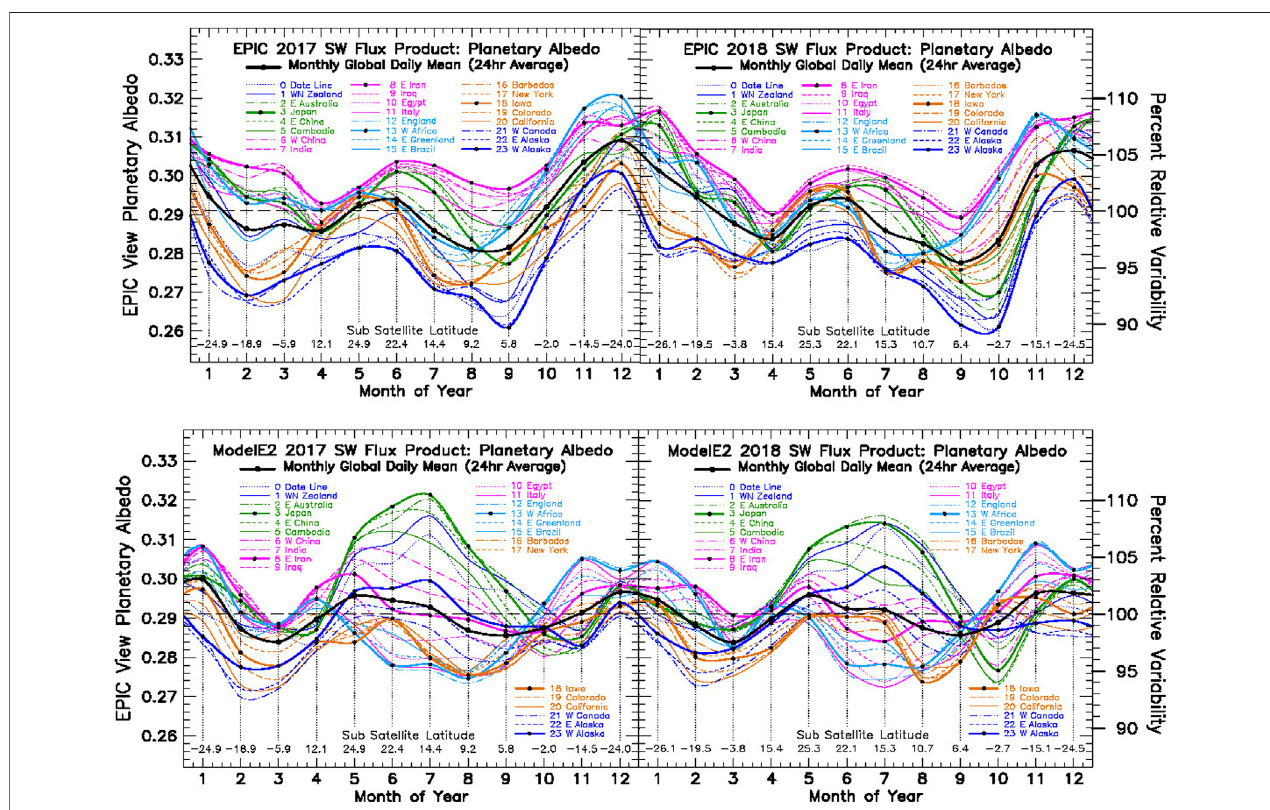
FIGURE 2 | Planetary albedo from EPIC re fl ected SW fl ux for 2017 and 2018 (Upper Left and Upper Right) , normalized by the CERES global annual-mean SW radiative fl ux(Loebetal.,2018),anddividedbytheseasonalTotalSolarIrradiance(KoppandLean,2011).Thelongitudinalslicingisdepictedbythecoloredlines,which representlongitudinallycontiguousregions,andwhichcorrespondtoGreenwich-meantimeofhigh-noonmeridiansthatarealso taggedwiththegeographiclocationof the illuminated hemisphere-center meridian. The representative members of each colored longitude grouping is identi fi ed by its designated black dot monthly- mean position. Geographically, the colored lines proceed westward from the international date line at 1- hourly intervals (15 ° of longitude). The heavy black line is the daily-mean average over a full rotation of the Earth. The mid-month DSCOVR sub-satellite latitude is depicted at fi gure bottom. Bottom Left and Bottom Right are the corresponding planetary albedo results for 2017and 2018 obtained from GISS ModelE2 simulations running with prescribed current-climate sea surface temperatures, and using in-line sampling of the GCM output data using SHS sampling in accord with the DSCOVR Ephemeris viewing geometry.